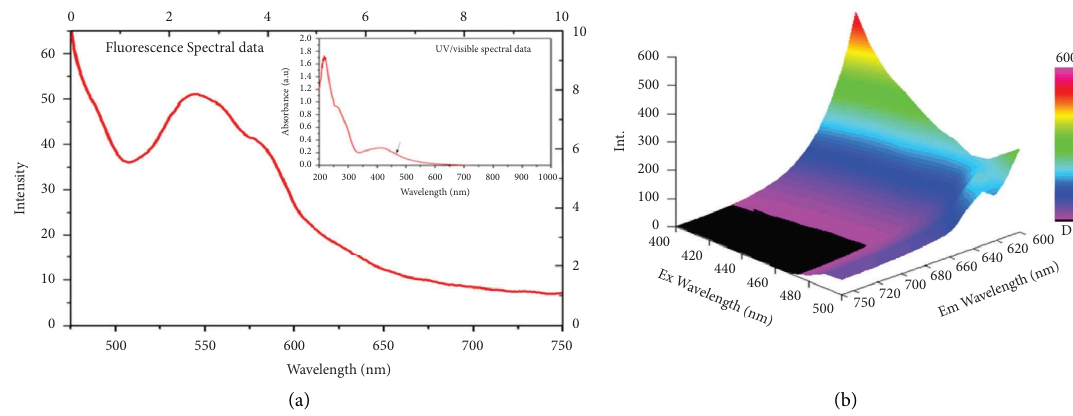
Figure 3: (a) Fluorescence spectral data of silver nanoparticles. (b) 3D fuorescence spectral data of silver